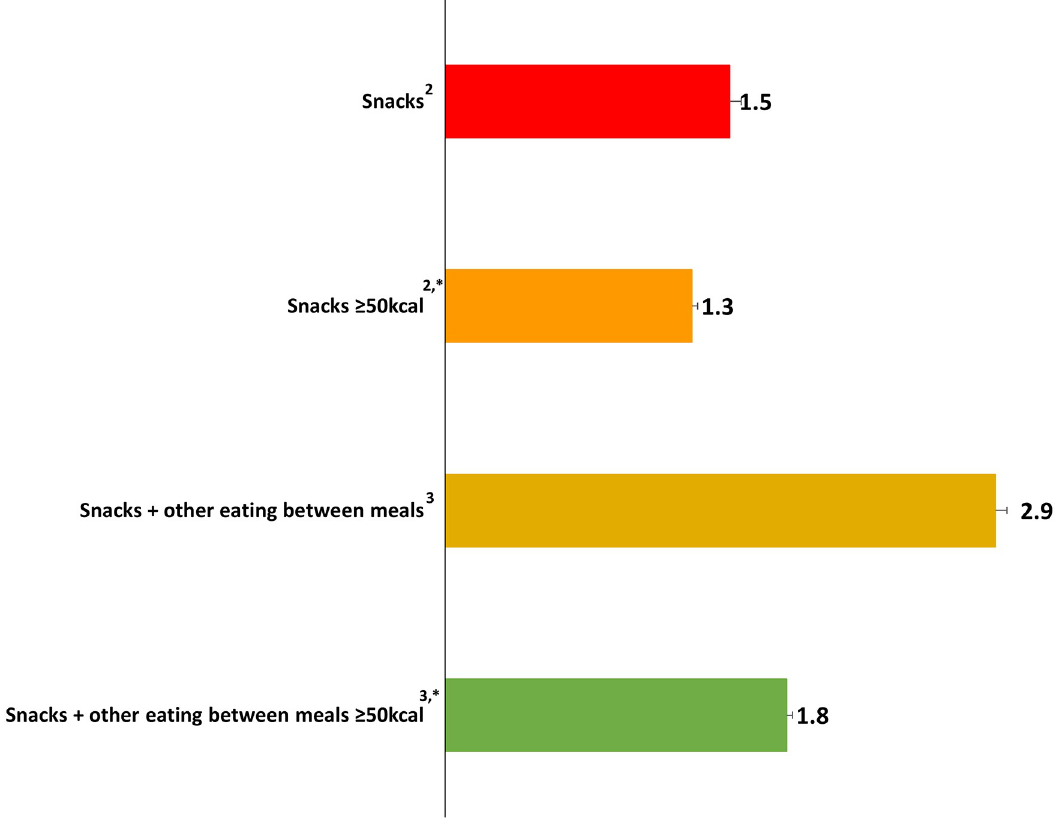
Fig 1. Mean number of snacks per day by snack definition among U.S. Adults ( � 20y), NHANES 2013 − 2016 1 . 1 Values are means unless otherwise indicated. An asterisk “ � ”denotes a snack defined as an event that contributed � 50 kcal. 2 Snack defined as an event defined by the reporter as a “snack.” 3 Snack defined as an event outside of a typical